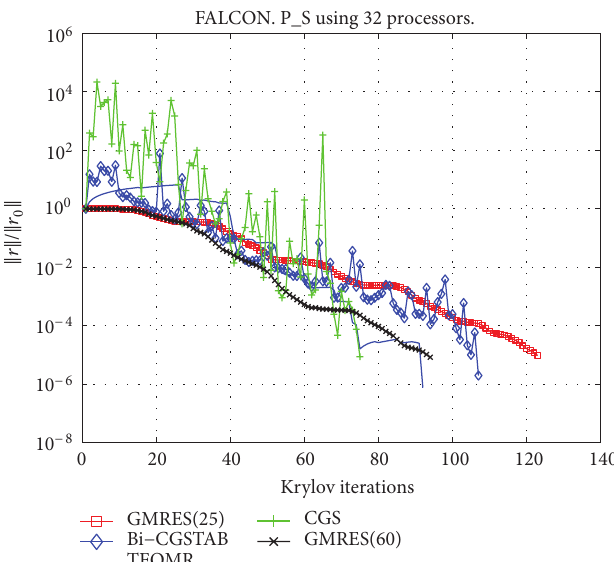
F 3: FALCON aircra. Convergence history at the 10th time level using 32 processors and various Krylov accelerators.